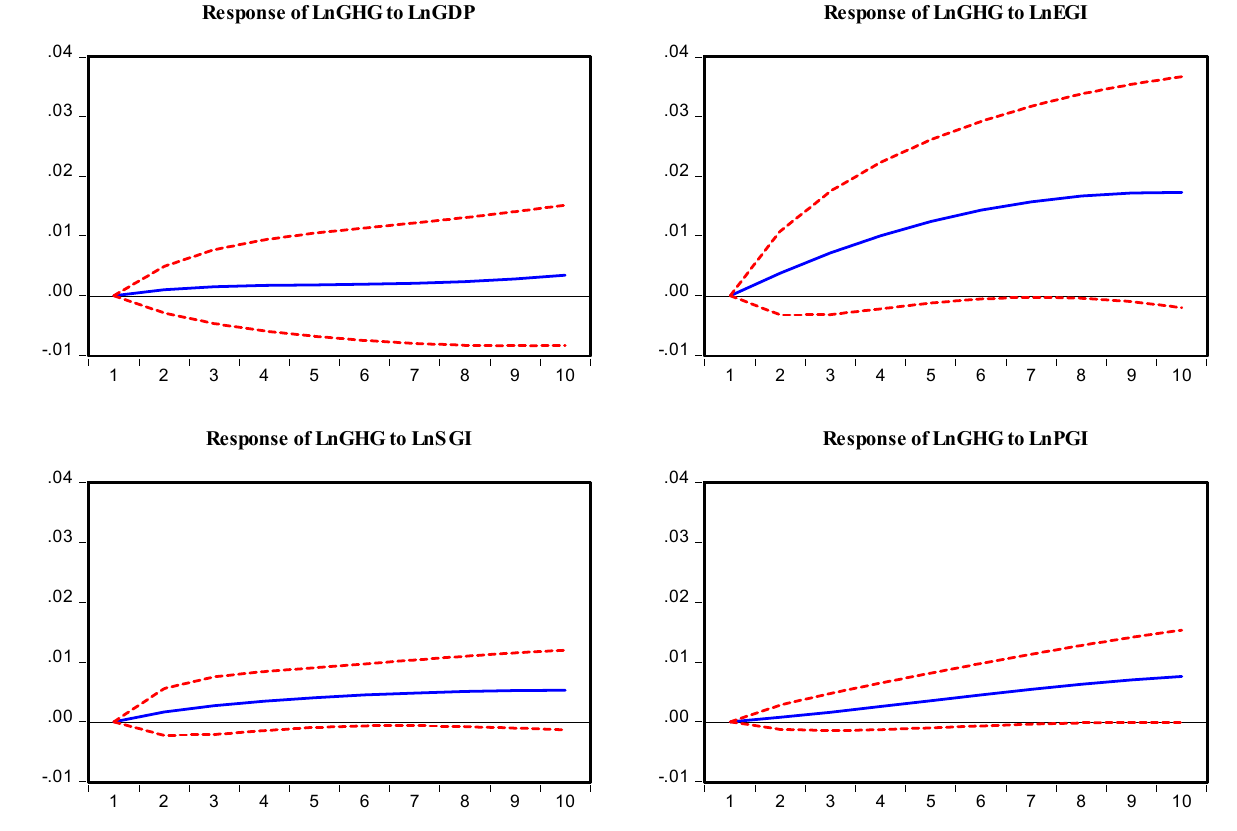
Figure 8. Response to Cholesky one S.D. Innovations ± 2 S.E.